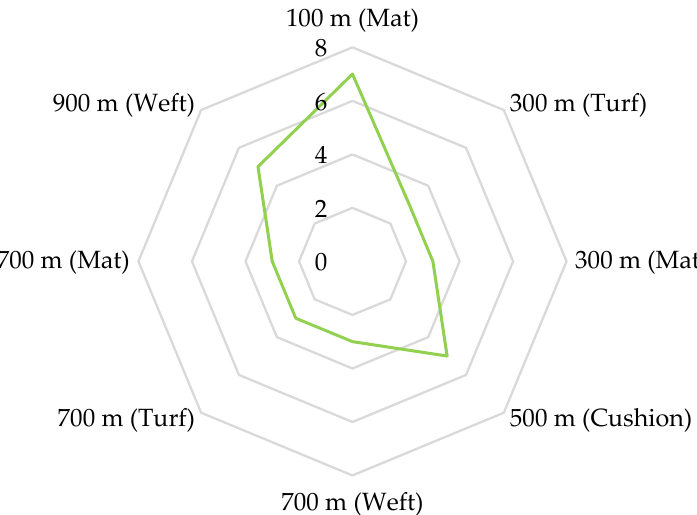
Figure 3. Dominant life forms of terrestrial mosses at five elevations.